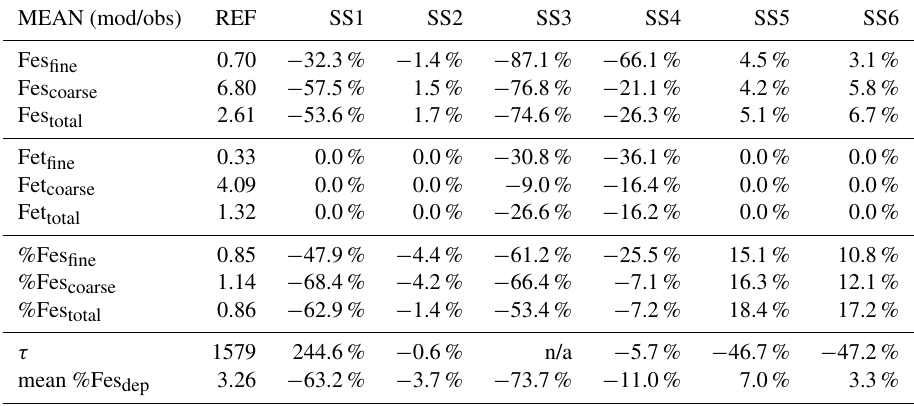
Table 7. Percent change for the MMO metric compared to the reference case for labile, total and percent labile iron in the fine mode ( < 1µm), the coarse mode ( > 1 and ≤ 10µm), and for the combined fine and coarse modes (0.1–10.0µm). The lower section of the table compares the percent difference for the average production lifetime of Fes (days) labeled here as τ and the average fractional iron solubility at deposition to global ocean